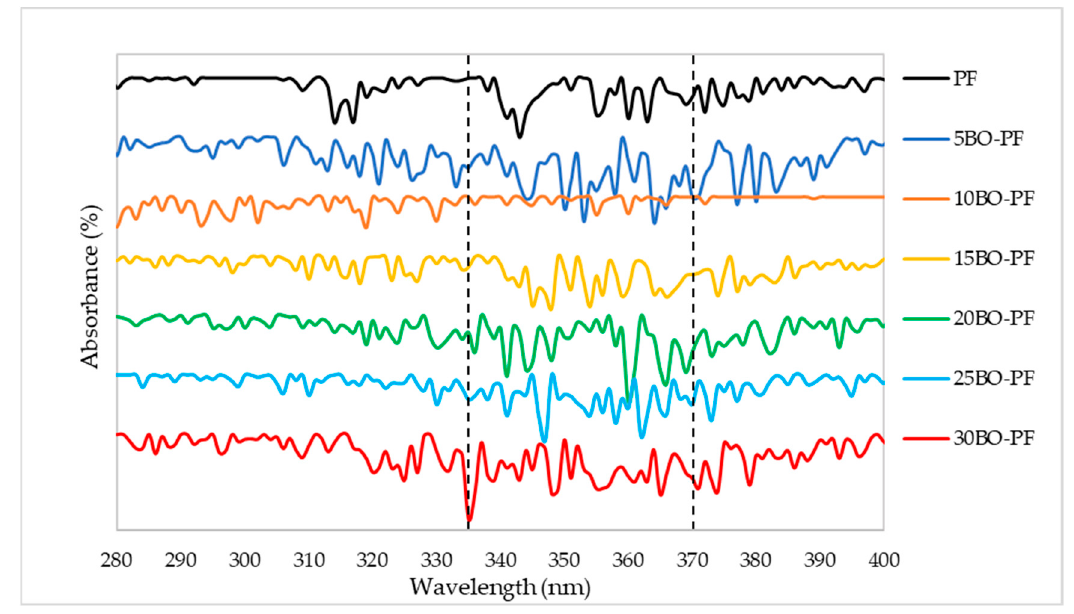
Figure 4. UV spectrum of the PL − PF resins from 5 to 30% phenol substitution rate.